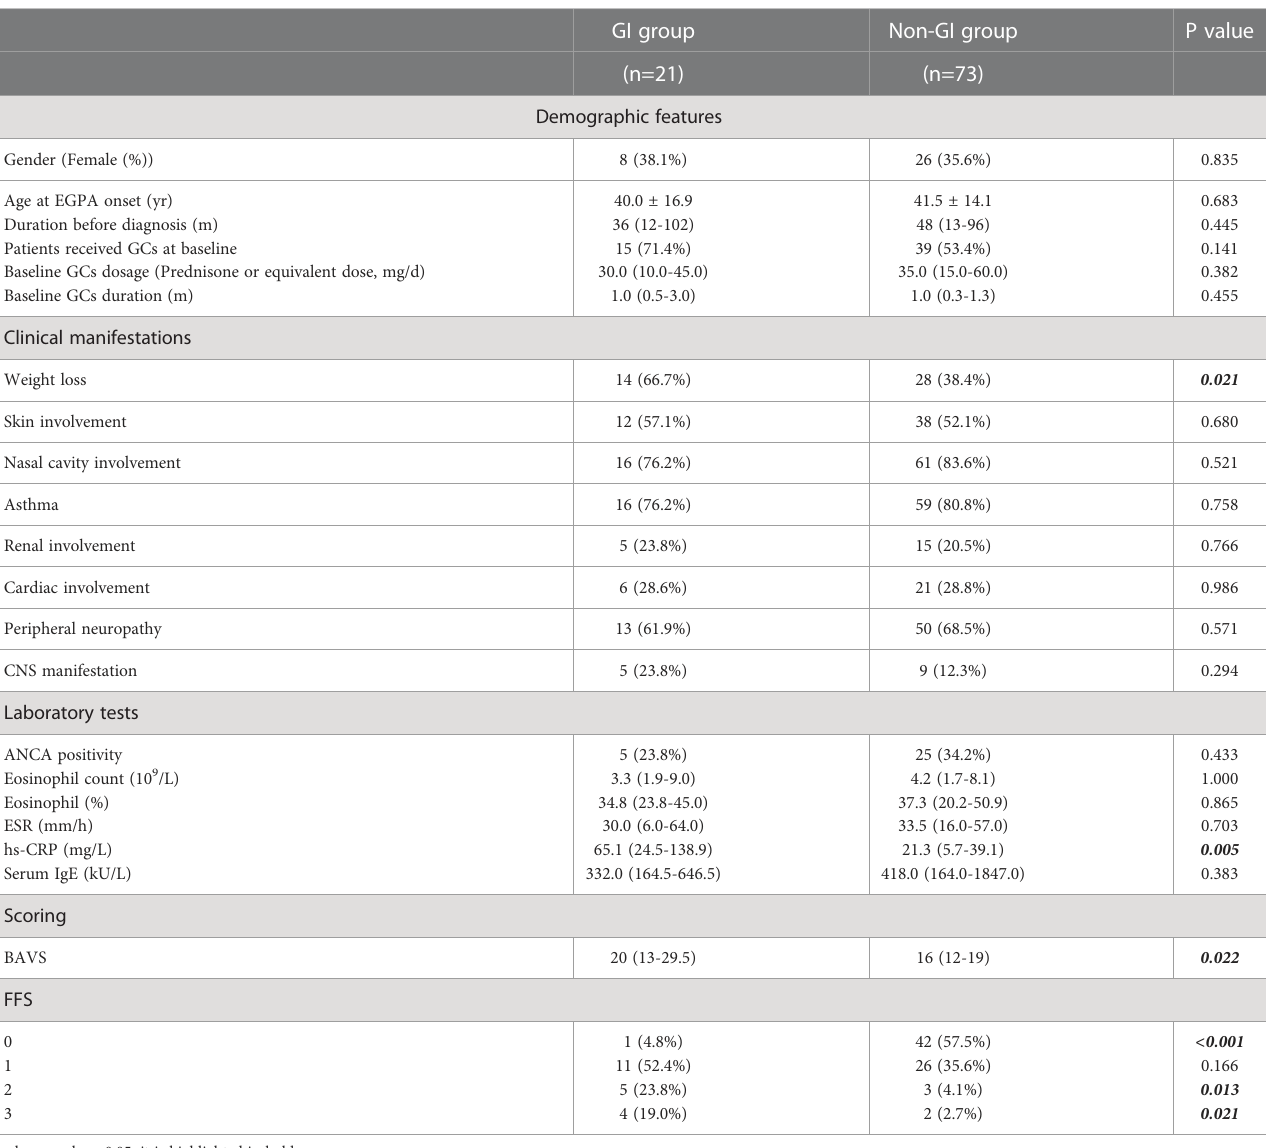
TABLE 1 Characteristics of EGPA patients with or without GI involvement.